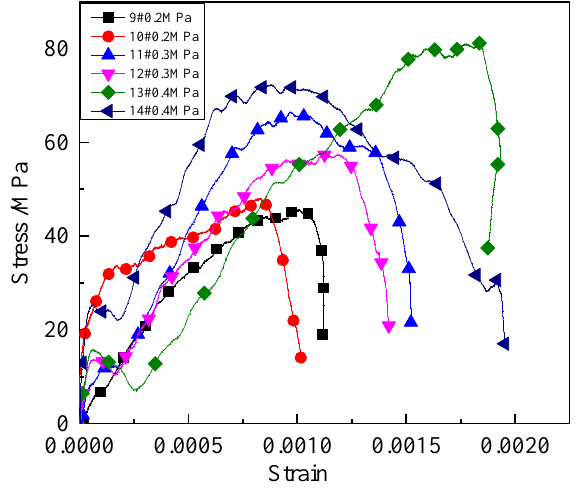
Figure 7. Stress–strain curves of sandstone-like materials under different impact